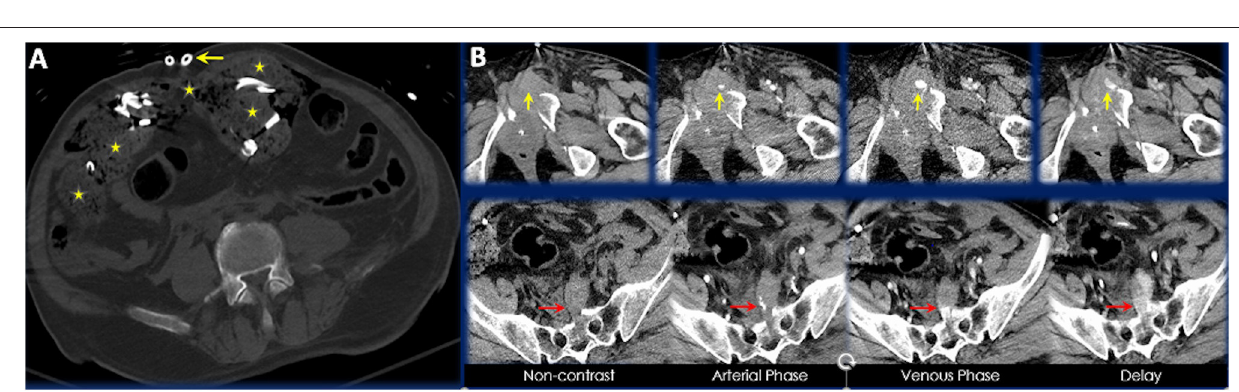
FIGURE 3 | (A) Axial CT image of a 70-year-old male presenting as a trauma alert red following motorcycle accident. Placement of surgical drains, retained laparotomy sponges, and preperitoneal hematoma are visible in this axial slice. (B) Axial CT images highlighting areas of contrast extravasation in different CT phases. Yellow arrows point to extravasation anterior to an acute comminuted left superior pubic ramus fracture and red arrows point to extravasation anterior to an acute comminuted sacral